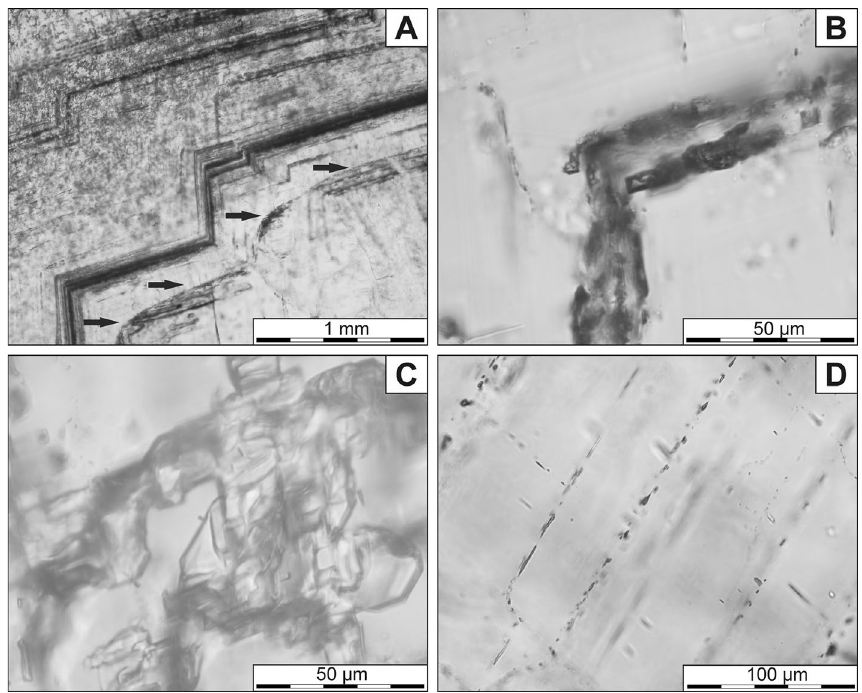
Figure 4. Fluid inclusions assemblages in barite crystals: ( A ) Arrangement of the first and second type of primary FIAs with densely packet inclusions (dark belts). Arrows show the second type of FIA emphasizing the presence of a blurred surface. ( B ) The inclusions in the first type of FIA. ( C ) The inclusions in the second type of FIA. ( D ) Arrangement of the third type of FIAs of primary